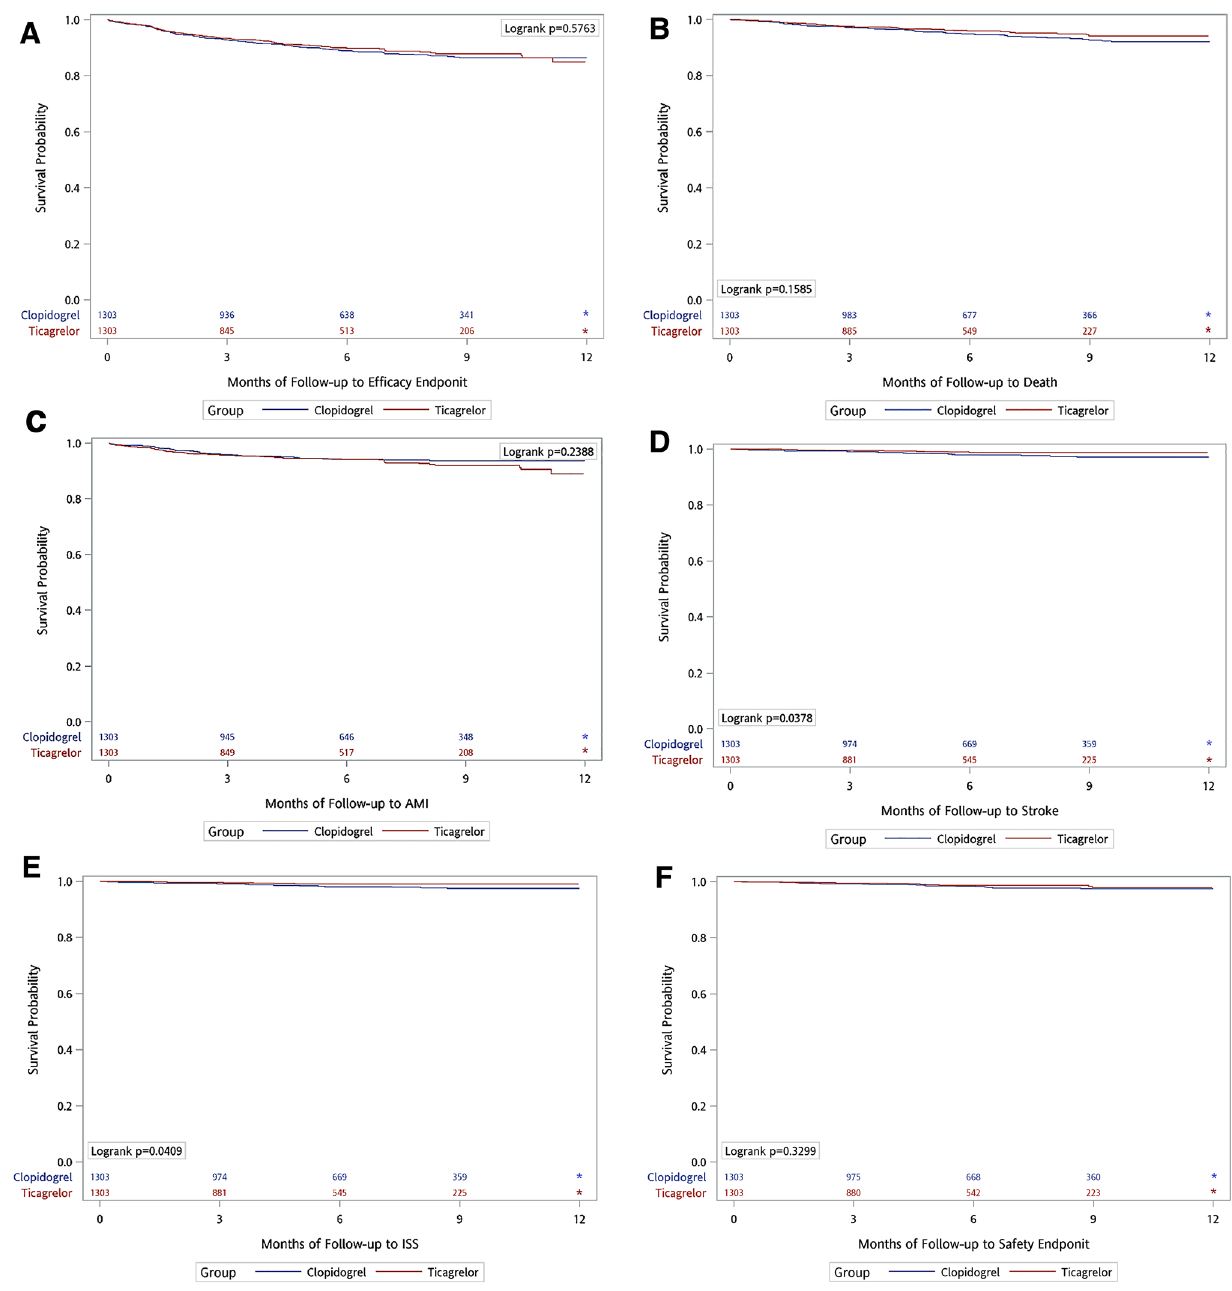
Figure 2. ( A , B , C , D , F ) *According to the regulation of NHIRD, data could not be present if the numbers of event were < 3. ( E ) ISS: Ischemic